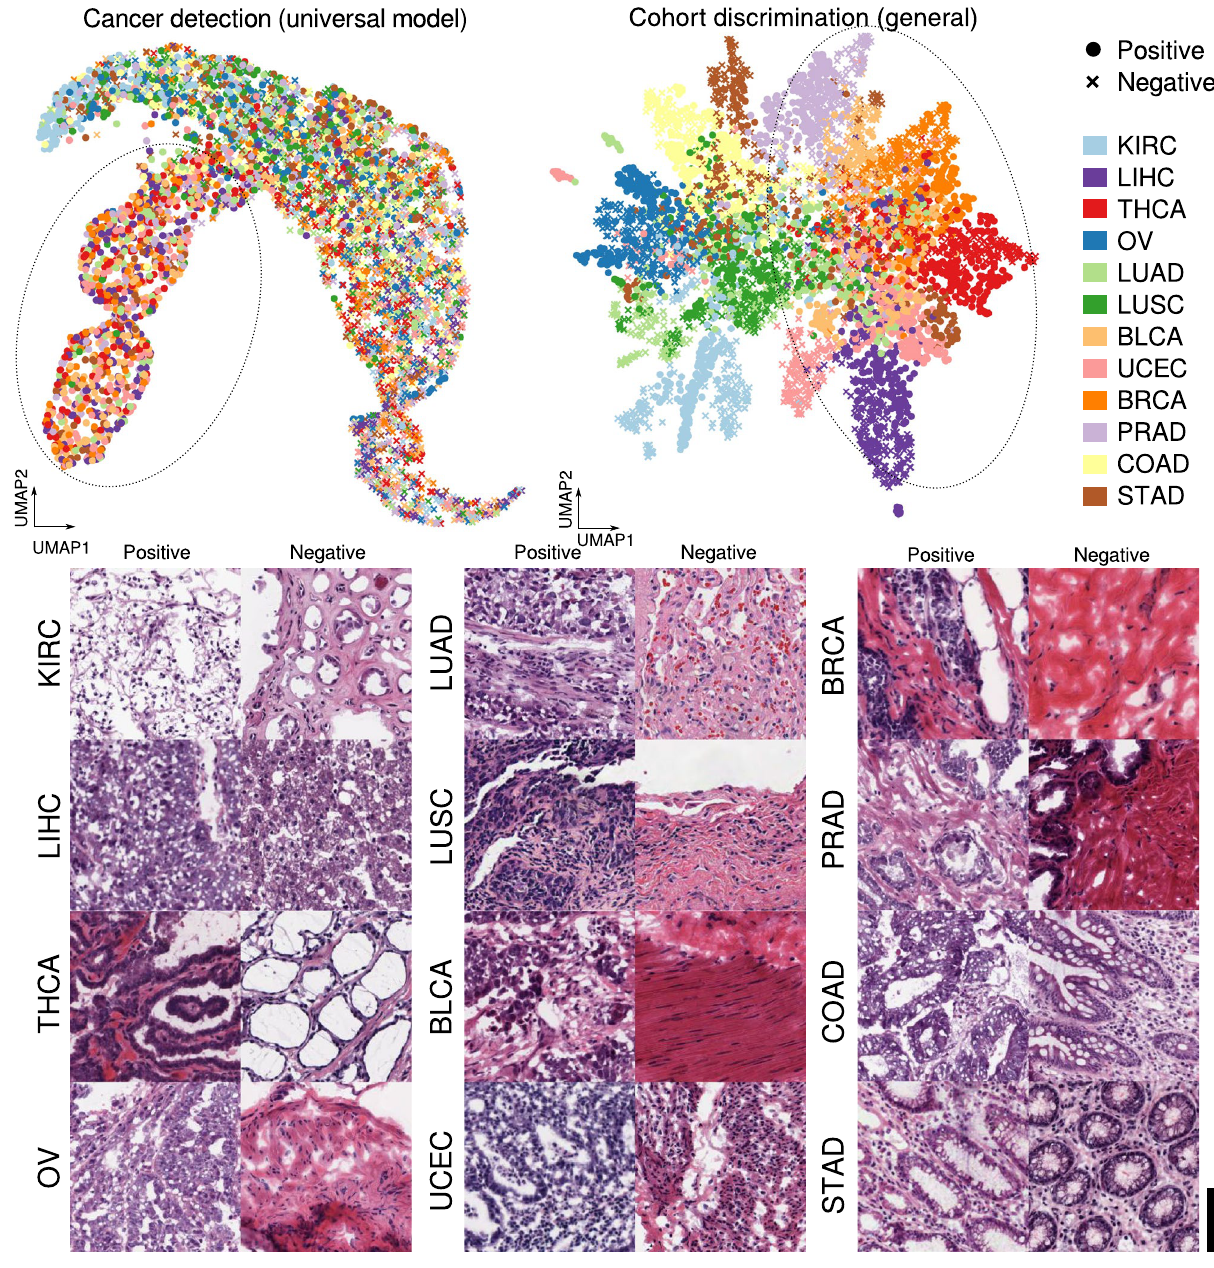
Figure 6. Uniform manifold approximation and projection (UMAP) visualizations for features extracted by the universal cancer detection model and general cohort discrimination model. Identical patches were used for both visualizations. Dotted ellipses indicate cohort mixtures (THCA–BLCA–UCEC–BRCA–PRAD–LIHC). Sampled positive and negative patches of all cohorts are shown below. KIRC is composed of clear cells and LIHC of eosinophilic polygonal cells that are distinct from others. THCA, OV, UCEC, and PRAD all show an adenocarcinoma pattern with differences in glandular contour and cytologic features. BLCA shows solid cancer cell nests. BRCA can manifest as both solid cell nests as in this patch or an adenocarcinoma pattern composed of small glands. STAD and COAD show relatively well-differentiated tall tubular structures. Scale bar: 100 µ